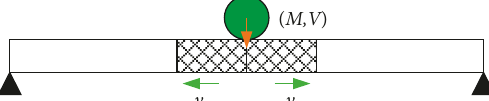
Figure 4: Propagation of stress waves in RC